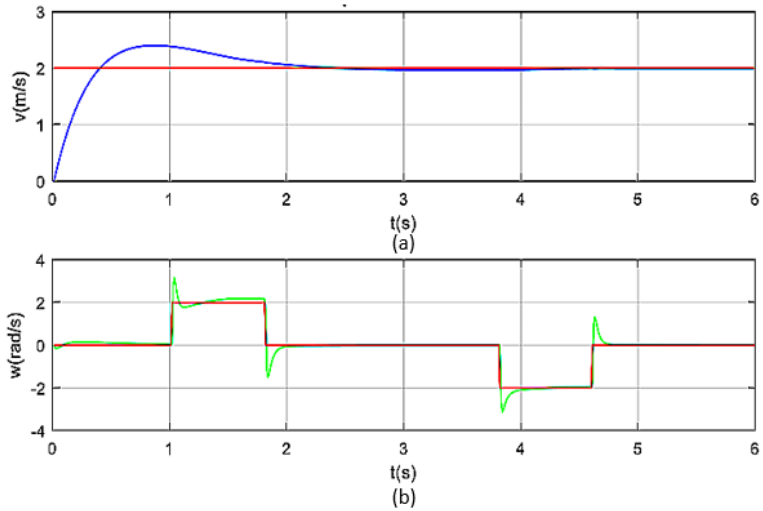
Figure 10. Real S-curve of working map ( a ) and tracking result with continuous linear and circular trajectory ( b ).